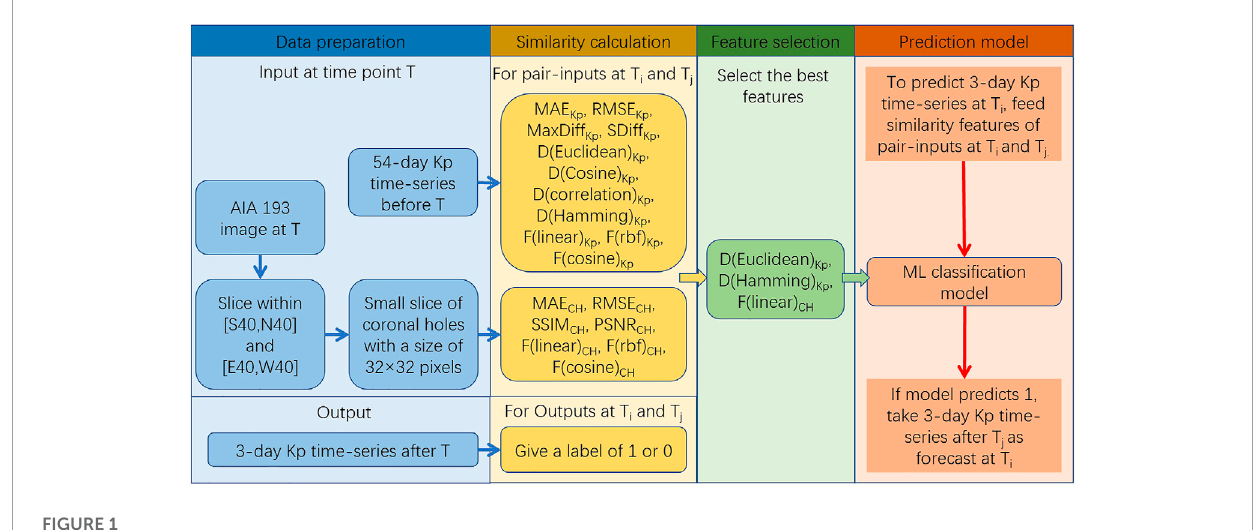
FIGURE 1 Flowchart of this study.